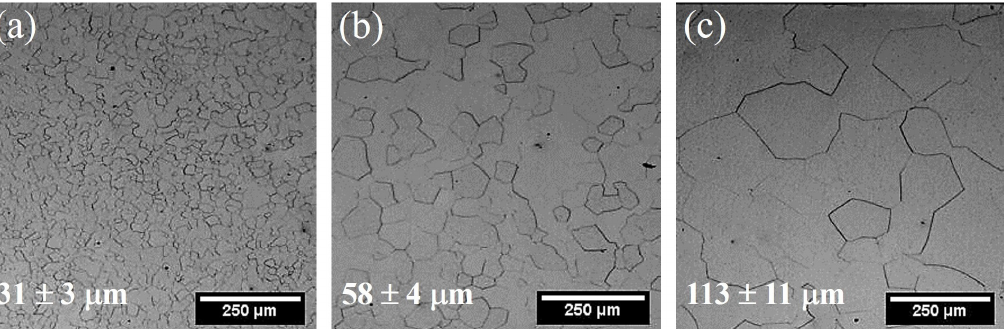
Figure 2. Optical micrographs and grain size of the microstructure obtained after recrystallization annealing at: (a) 700 ºC, (b) 800 ºC, and 900 ºC.